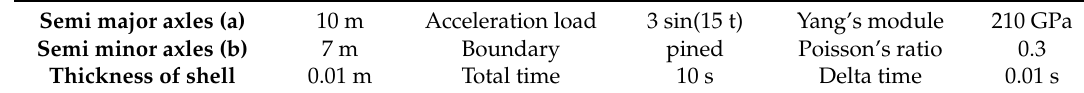
Table 2. Parameters of the FSI analysis.